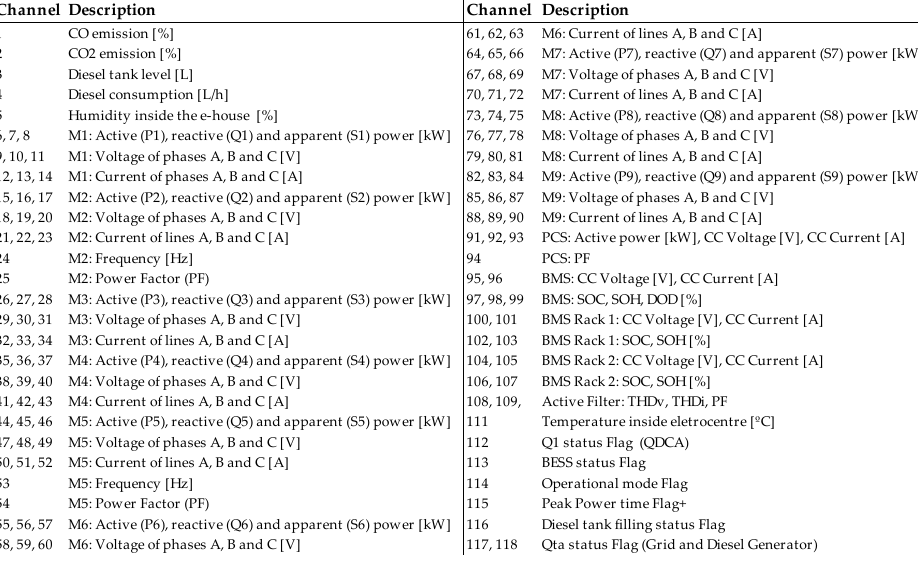
Figure 2. PU single-line diagram adapted from the Supervisory Control and Data Acquisition System (SCADA) [22].